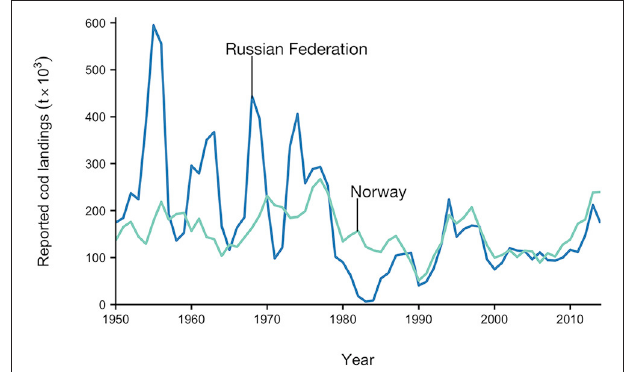
FIGURE 6 | Reported landings of cod ( Gadus morhua ) by both Norway and Russia in the Barents Sea. Norwegian reported landings of Barents Sea cod do not exhibit fluctuations in landings to the same degree that Russian reported landings of cod